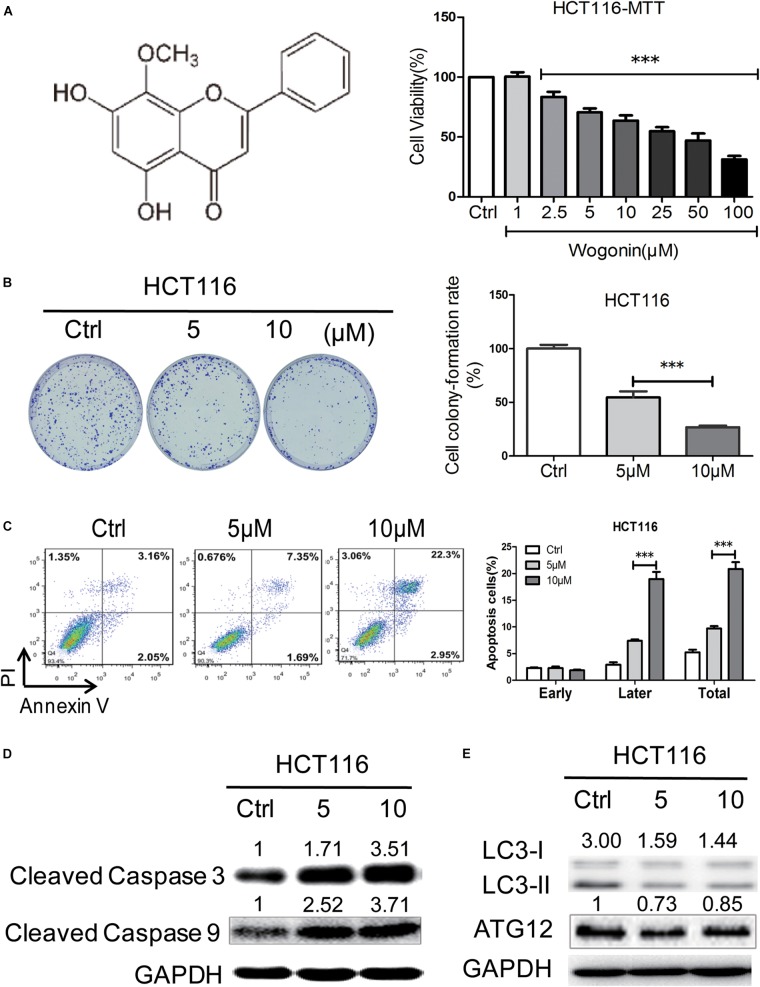
Wogonin induced cell death via caspase-dependent apoptotic pathway in human CRC cells. (A) Wogonin inhibited human CRC HCT-116 cells viability of in a concentration dependent manner. HCT-116 cells were treated with various concentrations (0–100 μM) of wogonin for 72 h as measured by MTT assay. (B) Effects of wogonin on the colony formation abilities of HCT-116 cells. Colony formation rate was showed in histogram. (C) Effects of wogonin on apoptotic cell death in HCT-116 cells. HCT-116 cells treated with wogonin for 48 h, and the proportion of apoptotic cells was determined by flow cytometry using Annexin V/propidium iodide (PI) double staining. (D) The expression levels of cleaved caspase 3 and 9 in9 in HCT-116 cells after wogonin treatment were measured using Western blot assay. GAPDH was used as an equal loading control. (E) Western blot analysis of autophagy-related proteins including LC3-II and LC3-I in HCT-116 cells after wogonin treatment for 72 h. GAPDH was used as an equal loading control. The results represent the mean of three independent experiments. Values represent mean ± SD, significant difference versus control group, ∗∗∗P < 0.001.